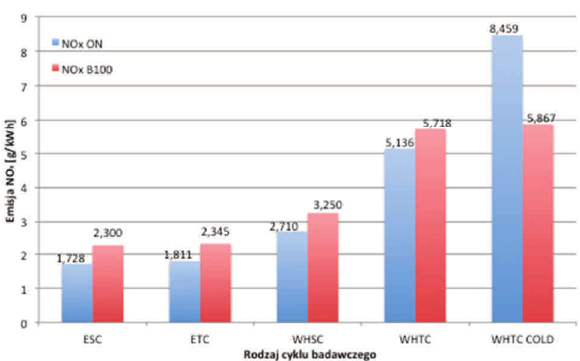
Fig. 10. Comparison of NO x emission with engine fuelled by diesel and B100, depending on the type of test